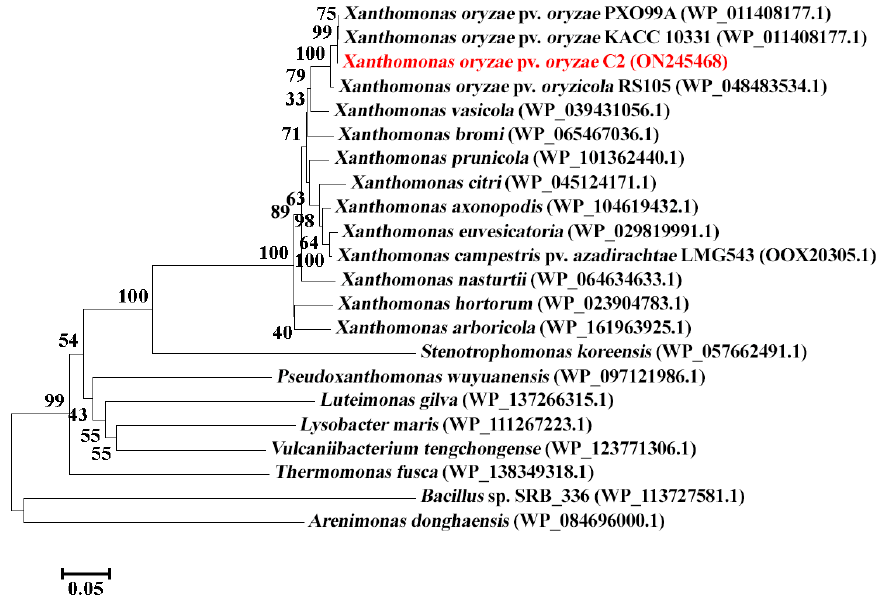
Figure 3. CDS2289 is widely distributed in bacteria. Phylogenetic analysis of CDS2289 glycosyl- transferase proteins from different bacteria. The phylogenetic tree was constructed by MEGA 6.0 using the neighbor-joining method. The other 21 glycosyltransferase sequences were collected from UniProtKB. CDS2289 in Xoo wild type C2 is shown in red.